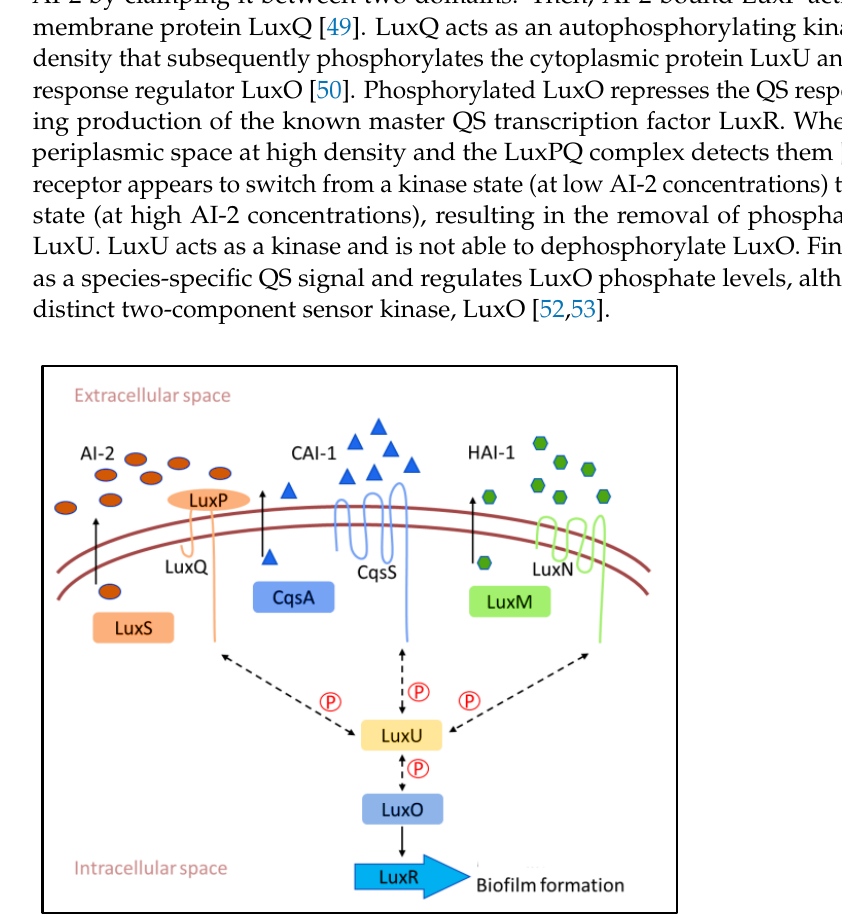
Figure 3. The quorum sensing mechanism of V. carchariae .